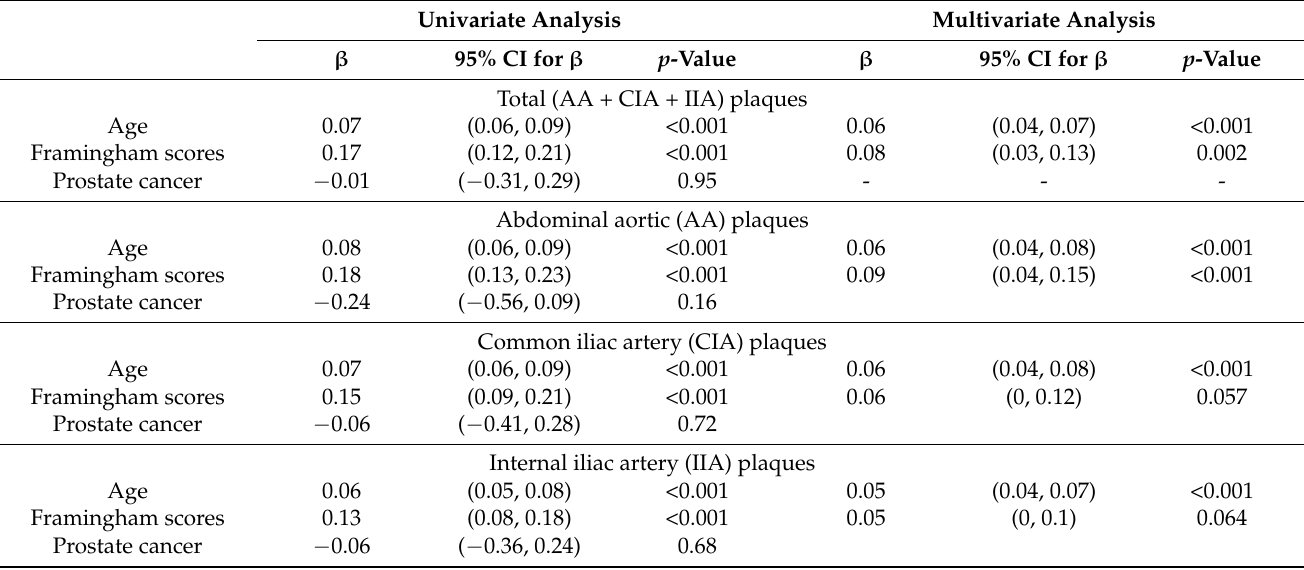
Table 4. Correlation of abdominal aortic and iliac Agatston scores with CVD risk factors: combined dataset of Cases and Controls.